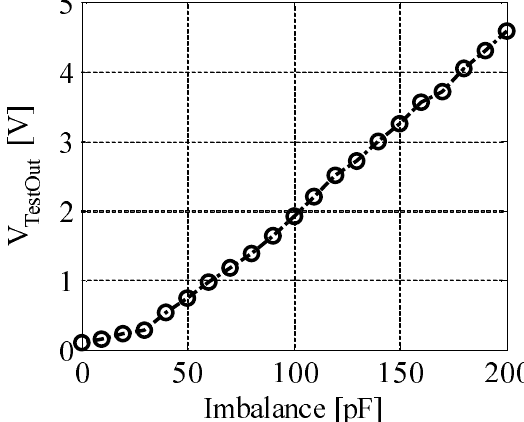
Figure 11. Correlation between the imbalance and the output of the injection signal (measured in experimental environments). When the absolute value of imbalance increases, the output voltage of test tone increases